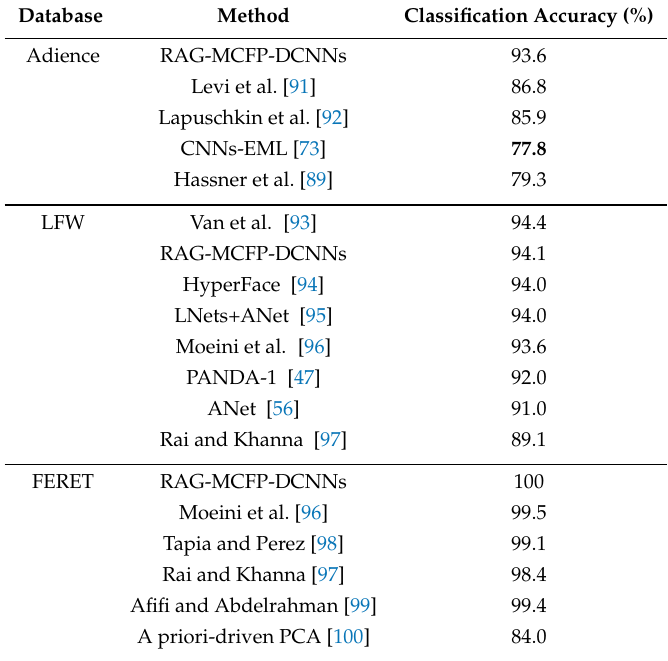
Table 8. Comparative experiments on gender recognition using Adience, LFW and FERET